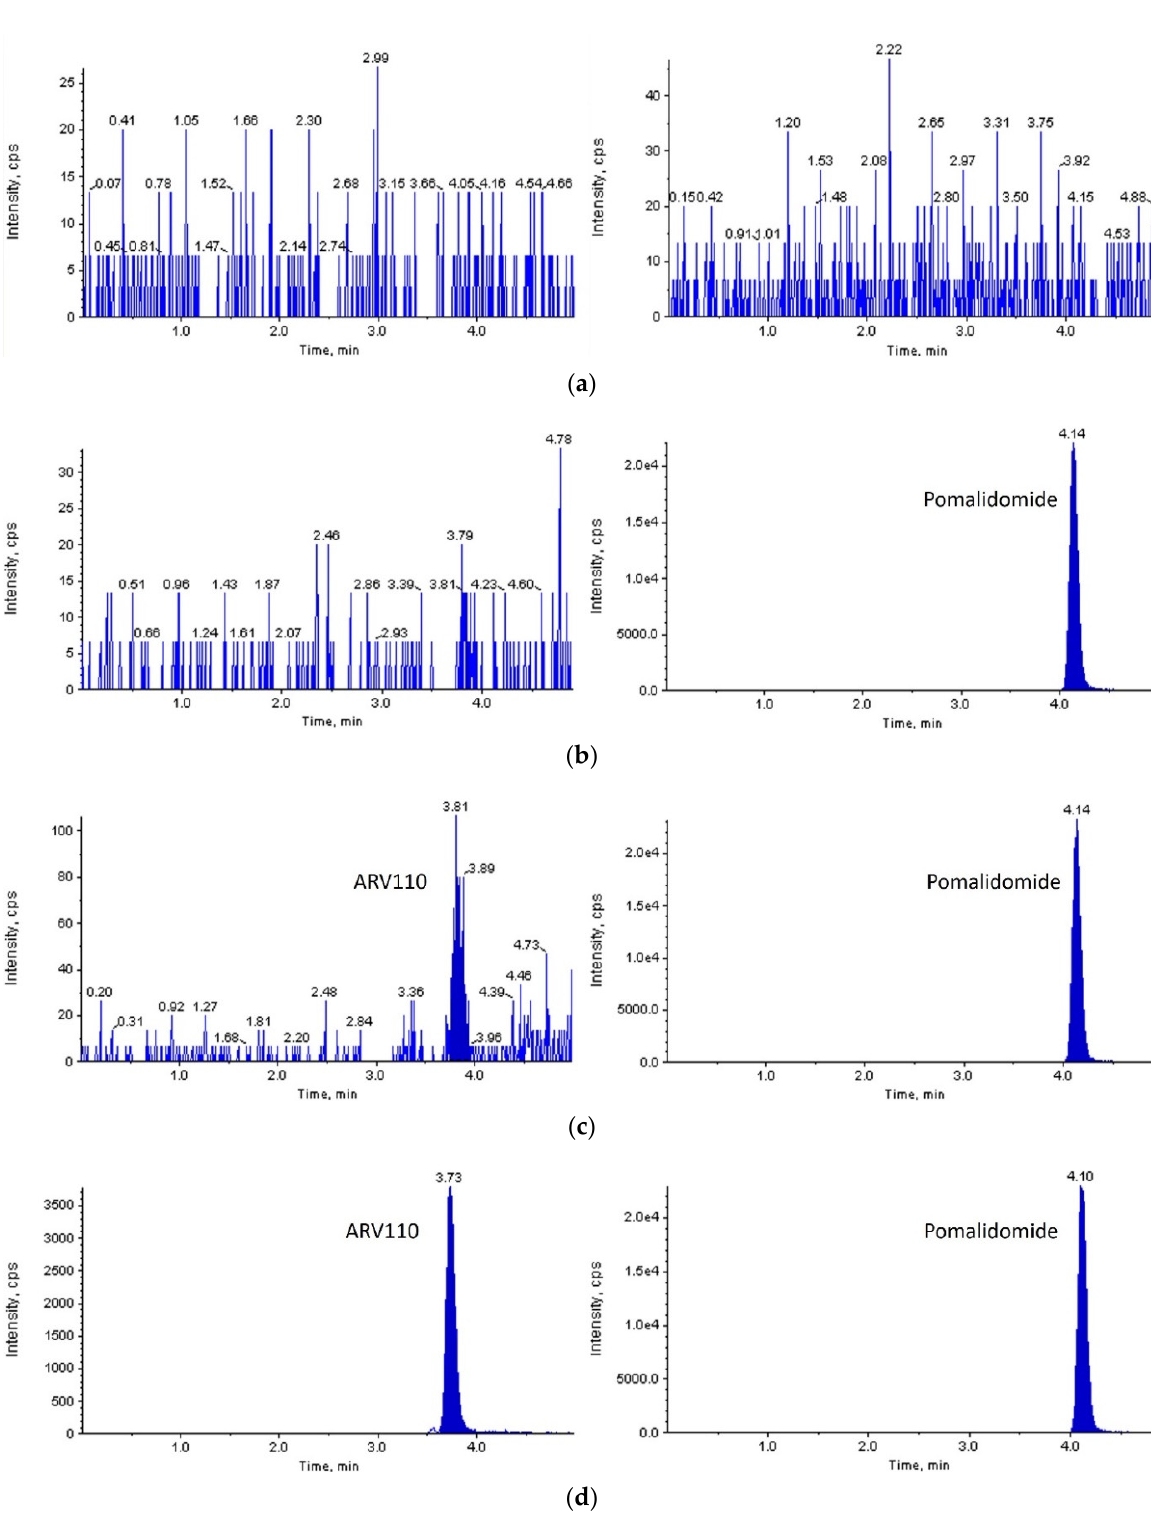
Figure 2. MRM LC-MS/MS chromatograms of ARV-110 (left) and pomalidomide (right) after depro- teinization of blank rat plasma ( a ); zero calibrator ( b ); LLOQ ( c ); and rat plasma sample 60 min after PO administration of ARV-110 at a dose of 2 mg/kg ( d